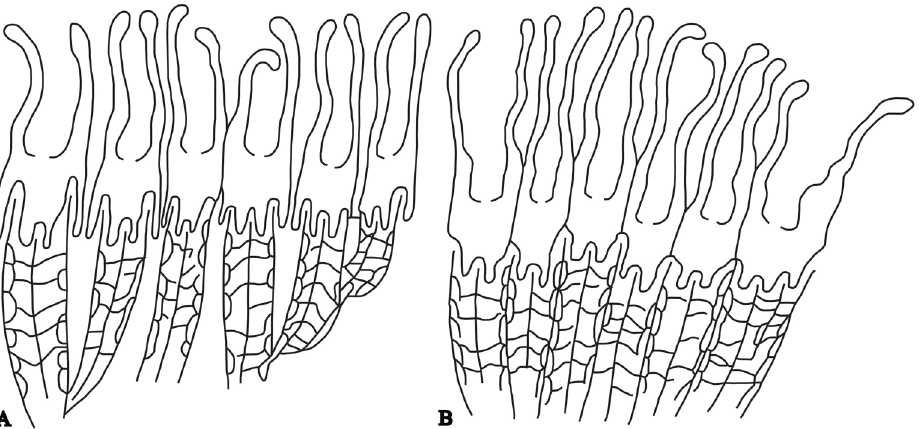
Figure 5. Sketch of coral cluster with upright growing morphology. Most reef-building corals in Langping grow vertically into cluster colonies. This type of morphology is very favourable for corals to get more living space and is important to reef-building. ( A ) Cluster coral individuals grow uprightly with certain distance between each other. ( B ) Polygonal columnar coral individuals grow closely to resist strong water flow. This figure is made